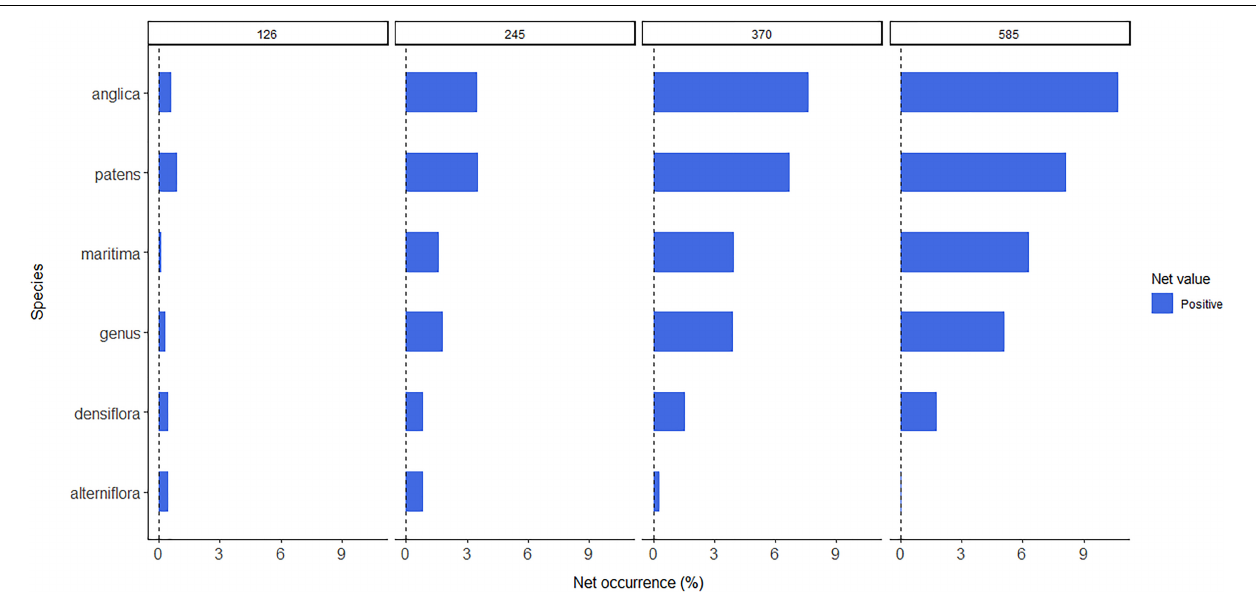
FIGURE 6 | Net change in occurrence increment probability (%) over time (between 2100 time and the historical period) for each Spartina spp. species (i.e., S. alterniflora , S. anglica , S. densiflora , S. maritima , and S. patens ) for each CMIP6 Shared Socioeconomic pathway (i.e., SSP1-2.6, 2-4.5, 3-7.0, and 5-8.5). The proportion of colonization and extinction for each species was quantified from the change in proportion of positive (gain), negative (loss), and null (no change) raster map cells between time periods. The percentage of colonization and extinction were then subtracted to obtain the net percentage change in predicted presences.